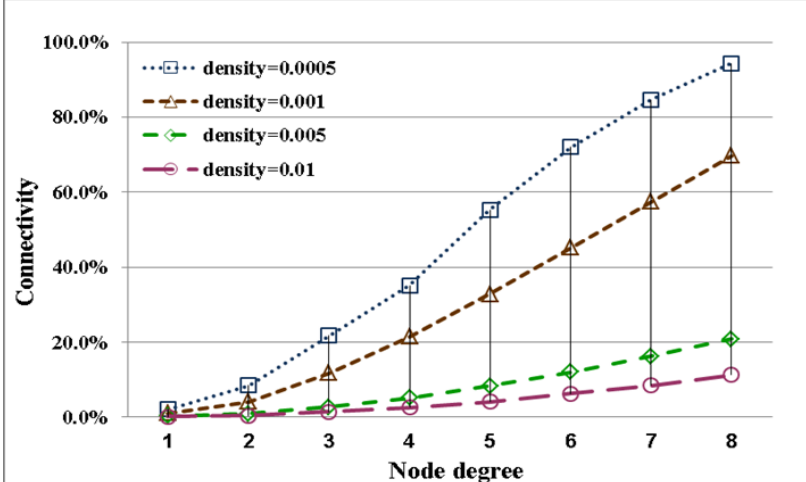
Figure 7. A comparison of the simulation results for connectivity with node degrees ranging from 1 to 8 with different node densities.